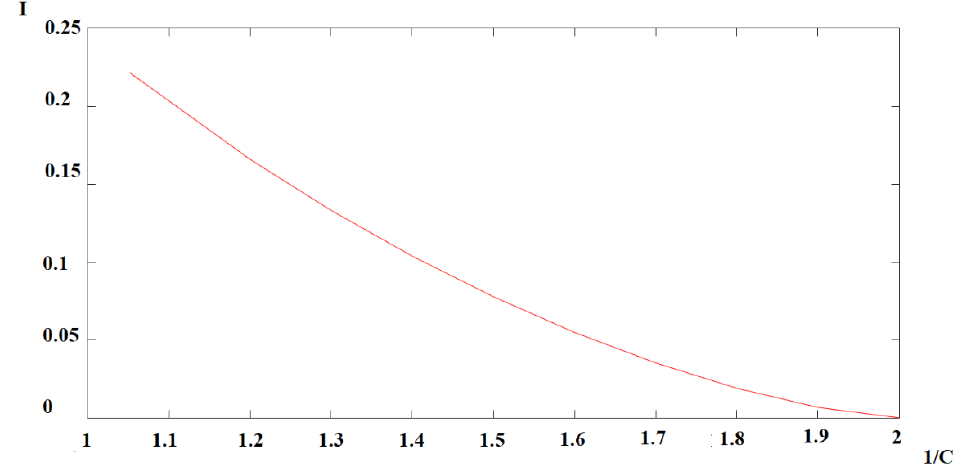
Figure 4. Relationship between work index (I) and compactness of the machine (C).